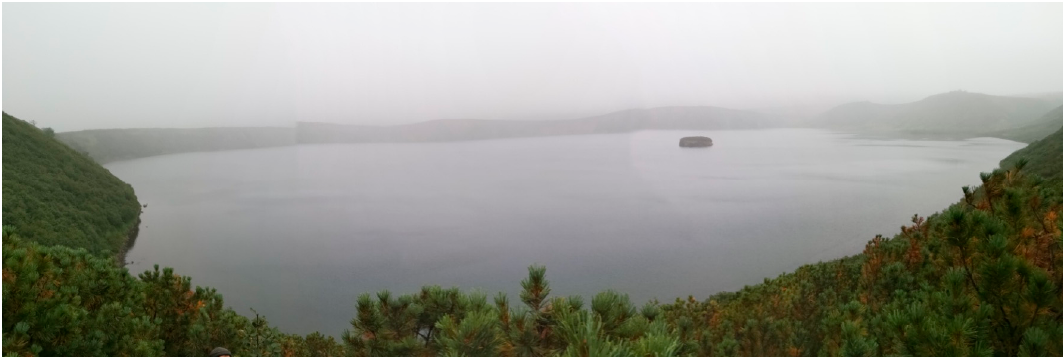
Figure A10. Dalneye Lake/Maar. Photo by A. Kiryukhin, 24 August 2019 .